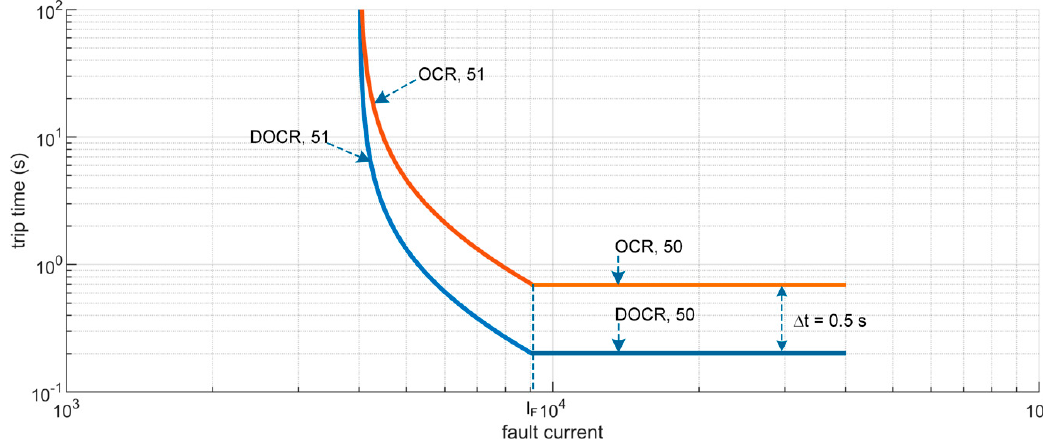
Figure 8. Protection coordination for the HTS cable system.